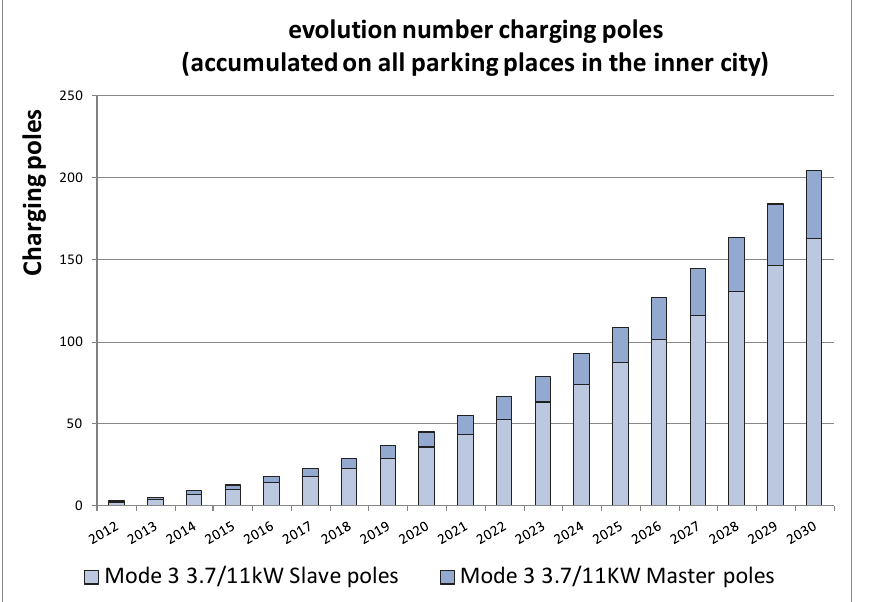
Figure 11. Evolution of the number of charging Poles in the inner city of Bruges (scen. D)